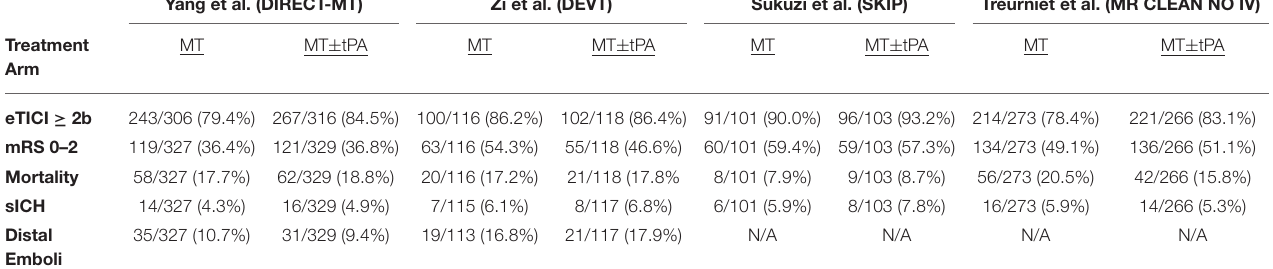
TABLE 2 | Angiographic, functional, and safety outcomes of patients in the four studies included in the meta-analysis. Yang et al. (DIRECT-MT) Zi et al. (DEVT) Sukuzi et al. (SKIP) Treurniet et al. (MR CLEAN NO IV)